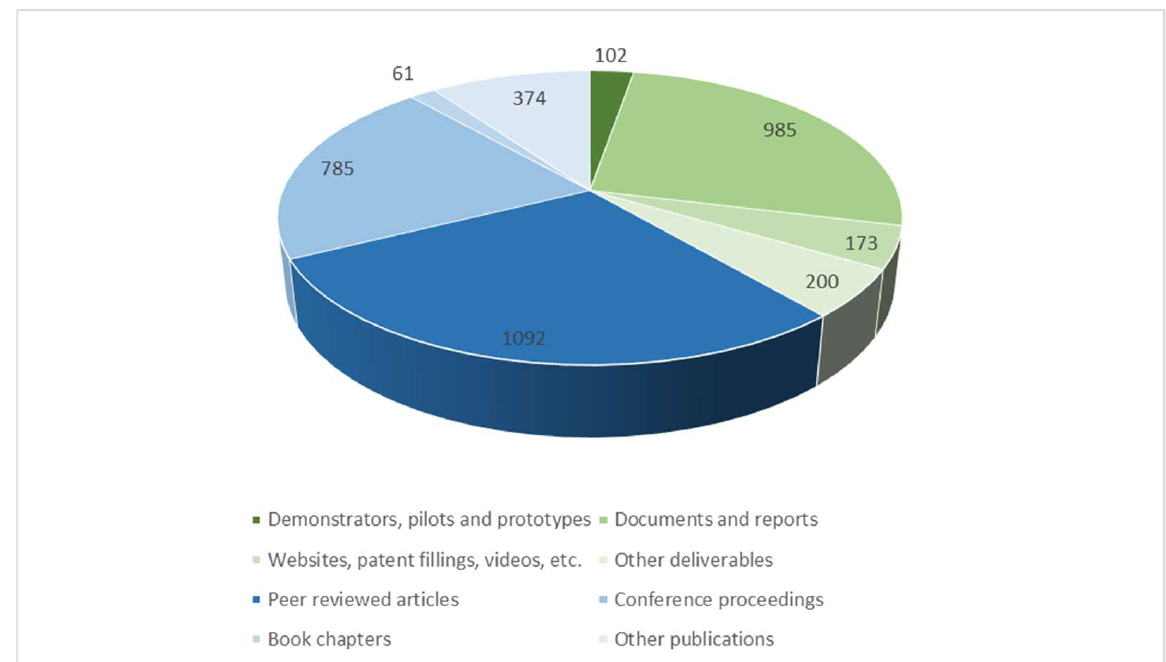
Figure 4. Project deliverables and scientific production.